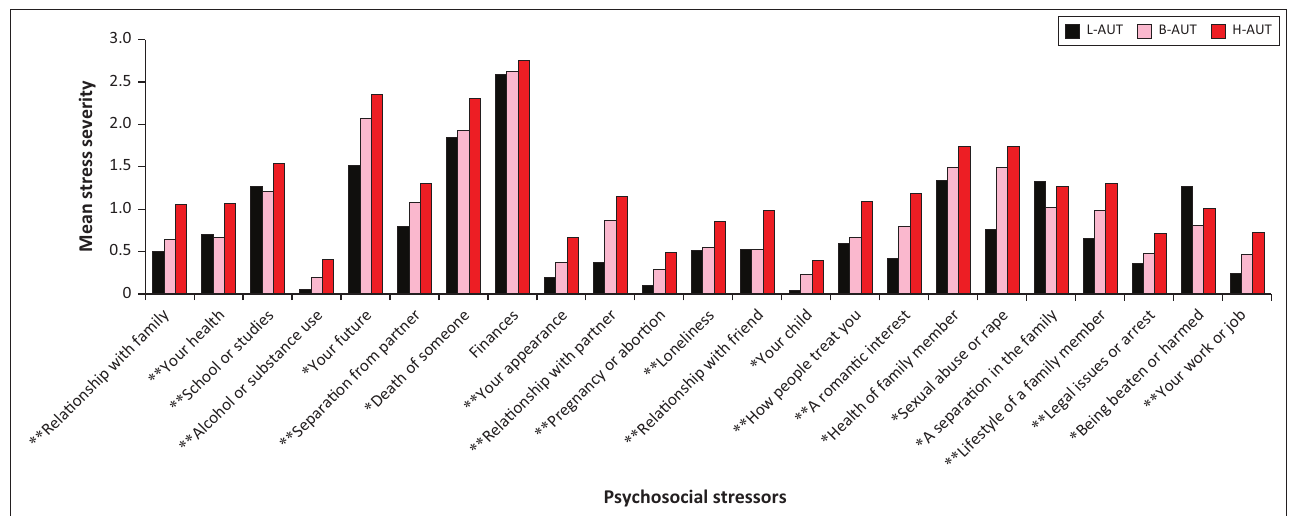
H-AUT = high autism trait group with scores of 32 or higher (on the autism spectrum quotient). B-AUT = borderline autism trait group with scores of 26–31. L-AUT = low autism trait group, with scores of 25 or lower. ** , p < 0.0001; * , p < 0.01. FIGURE 3: Psychosocial stressors across groups. Figure represent mean item scores on the Washington Early Recognition Center (WERC) Stress Screen in each group.